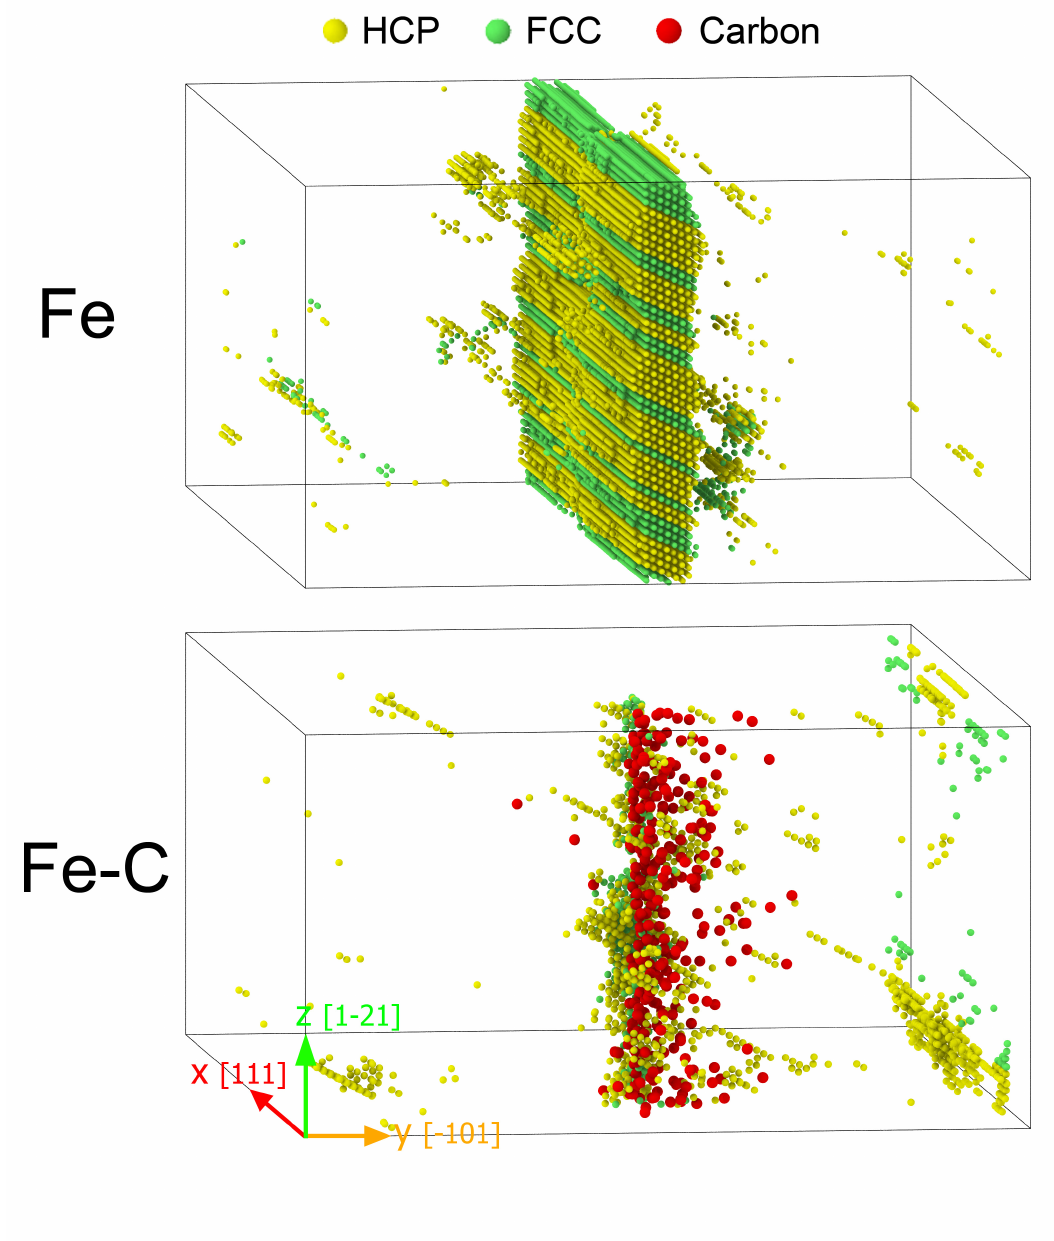
Figure 12. Snapshots of the dense phase at 6% strain of the sample containing an edge dislocation and a Cottrell atmosphere are shown on top and bottom, respectively. Atoms are colored by their local structure or atom type (red, carbon; yellow, hcp; green,